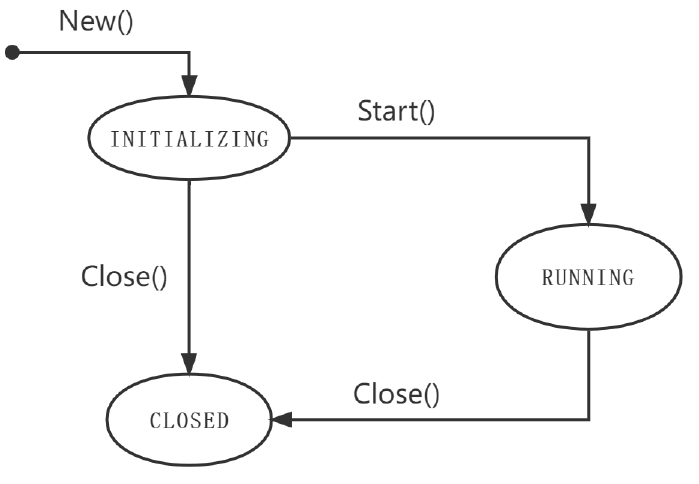
Figure 9. State transition relationships of nodes in the simulation